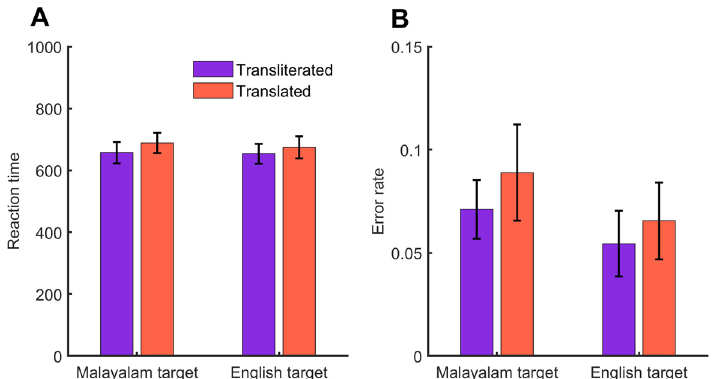
Figure 1. Reaction times ( A ) and error rate ( B ) across the conditions. Error bars represent standard error of mean.